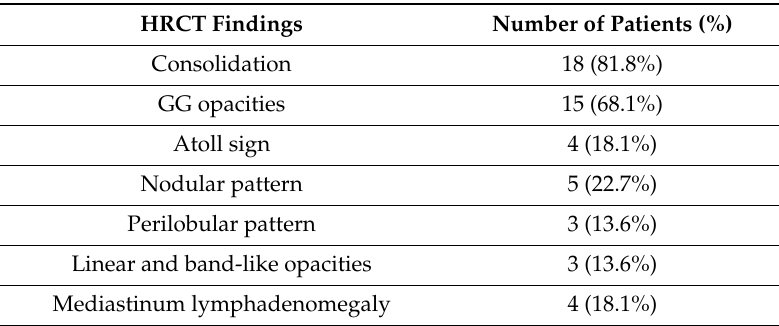
Table 4. Most common HRCT findings at